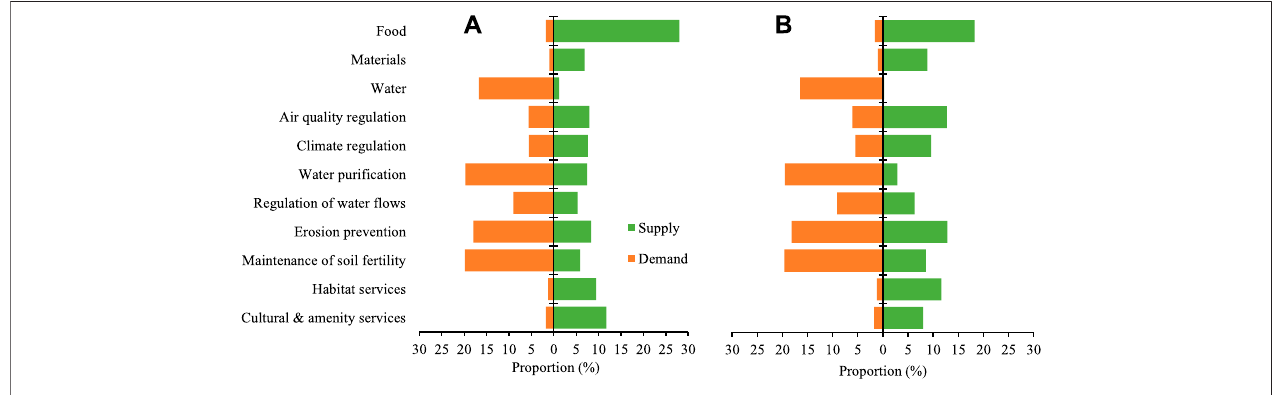
FIGURE 7 | Quantitative structure of supply and demand of ecosystem services in typical hilly areas of SW China at the regional scale (A) and the small scale (B) .